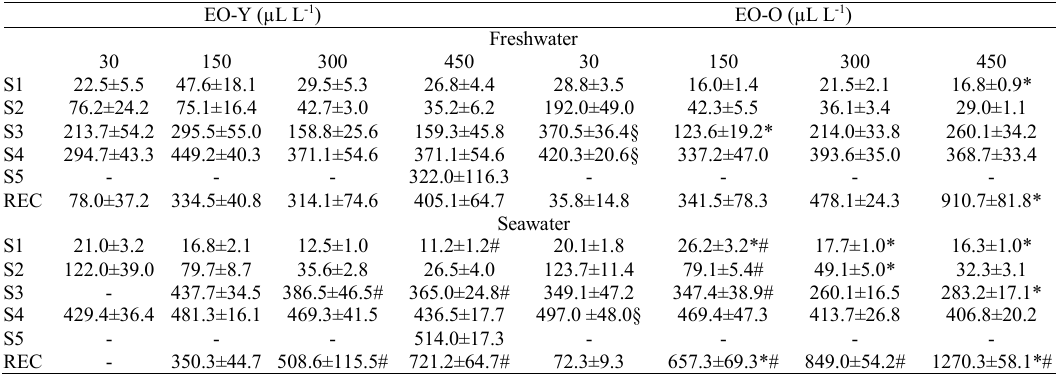
Table 2. Time (in seconds) required for induction and recovery from anesthesia using the essential oil of Nectandra megapotamica in fat snook. Stages are according to Stoskopf (1993): S1, slight loss of reactivity to visual and tactile stimuli; S2, partial loss of equilibrium; S3, total loss of equilibrium; S4, reduced opercular movement; S5, minimal opercular movement; REC, recovery of equilibrium and swimming actively; Maximum observation time was 10 min. N = 8 for each concentration tested. §, number of observations lower than 3 (data not used for statistical comparison); *, significantly different from EO-Y in the same salinity; #, significantly different from freshwater with the same essential oil; -, stage not reached by any of the animals.